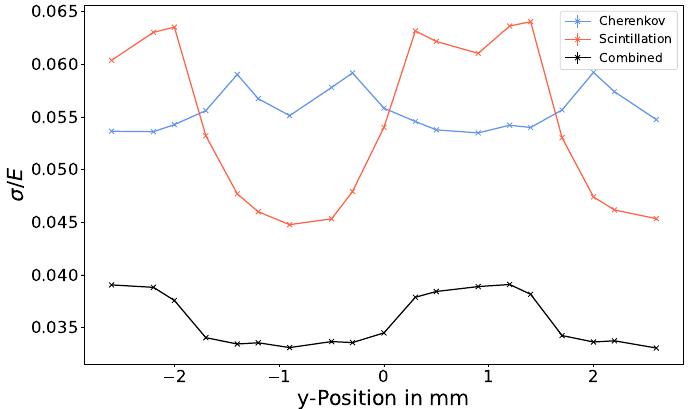
Figure 5. Energy resolution as a function of the beam impact position for the Cherenkov, scintillation, and combined channel.